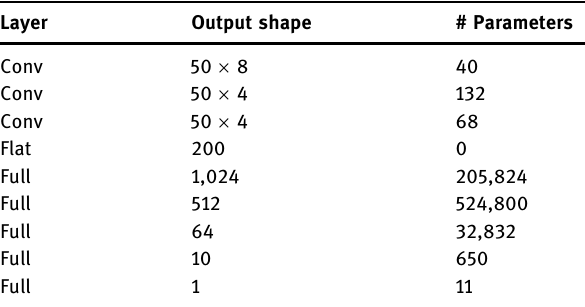
Table 2: Di ff erent layers that are used in the CNN used in our